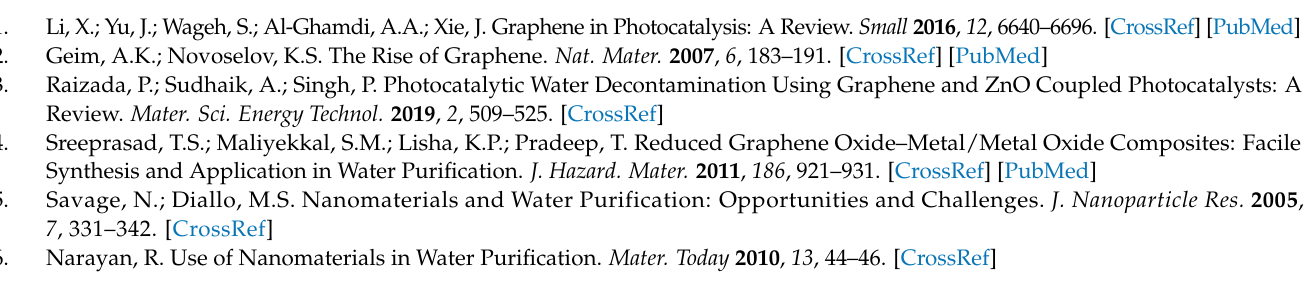
foliated graphene sheets (EGS) and graphite powder; Figure S2: UV-Vis absorption spectrum of graphene dispersion; Figure S3: TEM micrograph of graphene